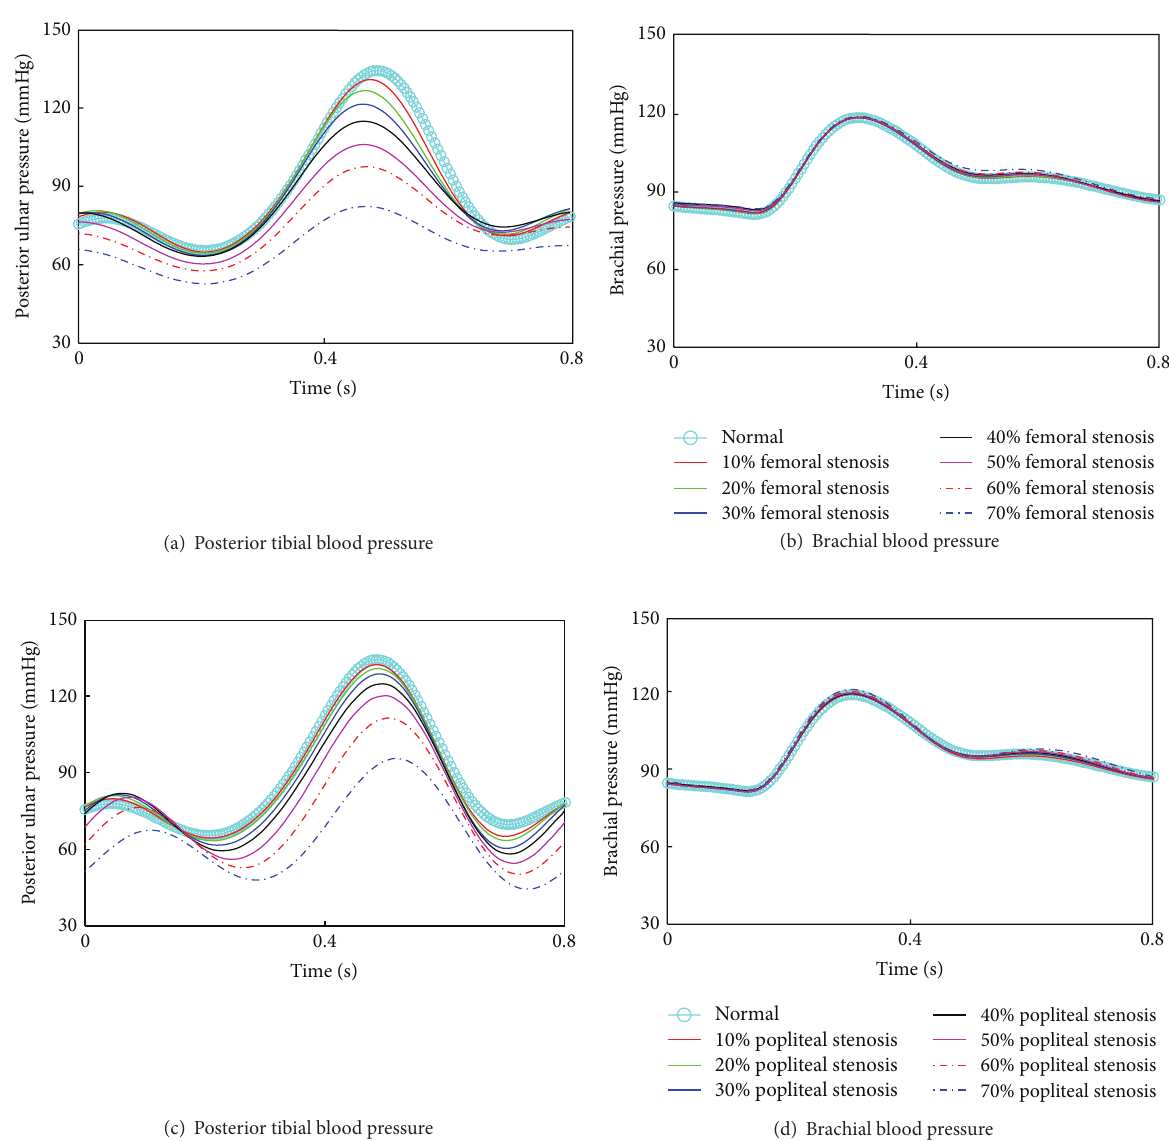
Figure 8: Blood pressure in a single cardiac cycle of posterior tibial artery and brachial artery with stenosis severities increasing from 0% to 70%. (a), (b): Stenoses located in femoral artery; (c), (d) Stenoses located in popliteal